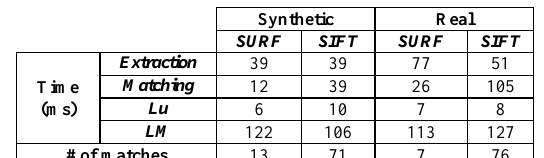
C OMPARISON TABLE OF TIMES AND # OF MATCHES FOR THE KB ALGORITHM